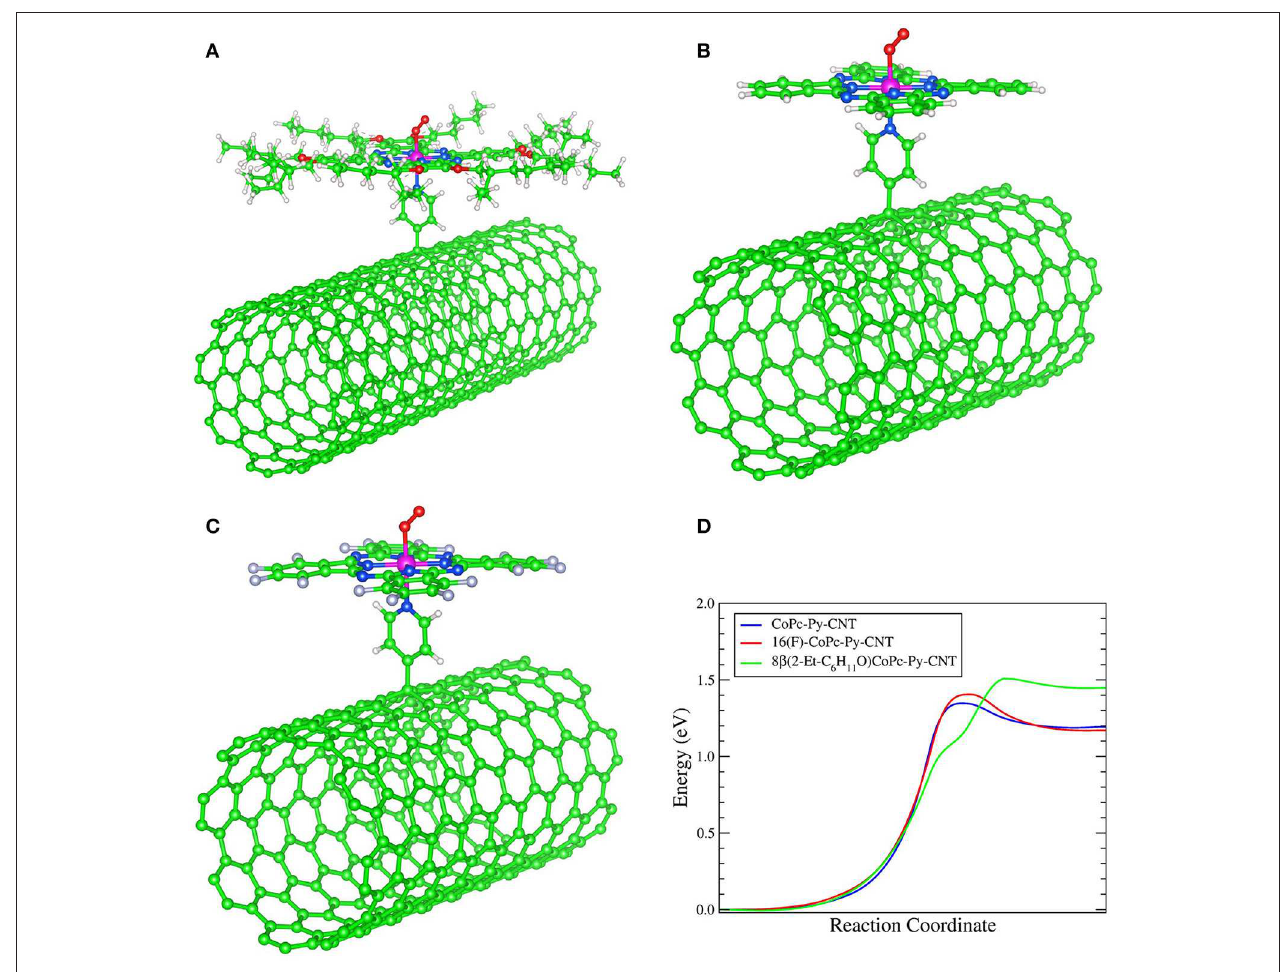
FIGURE 4 | Equilibrium geometry of O 2 adsorbed in the end-on configuration on the Co center of: (A) 8(2-Et-C 6 H 11 O)CoPc-Py-CNT, (B) CoPc-Py-CNT and (C) 16(F)CoPc-Py-CNT. (D) Minimum energy path for the *O 2 dissociation on the Co center in 8(2-Et-C 6 H 11 O)CoPc-Py-CNT, CoPc-Py-CNT, and 16(F)CoPc-Py-CNT.